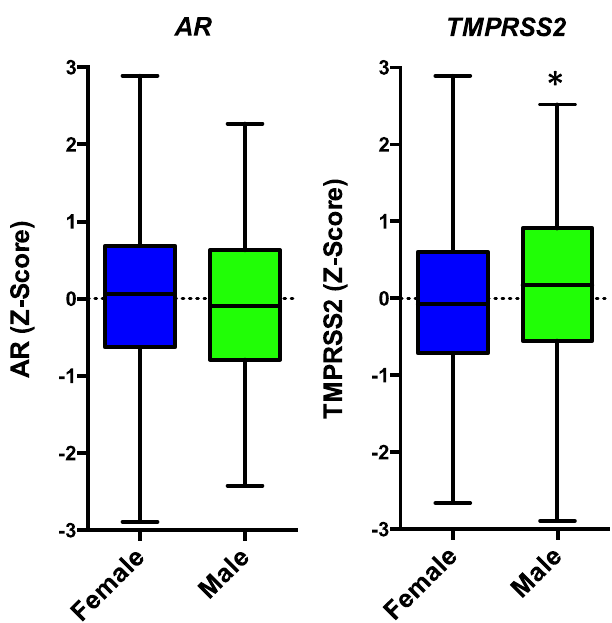
Fig. 3 TMPRSS2 is expressed at higher levels in the male lung compared to female lung. The GTEx dataset 40 was interrogated and expression of AR and TMPRSS2 investigated in lung tissue and dichotomised by gender, M = male ( N = 220), F = female ( N = 355). Box and whiskers: the centre line represents the median, the box represents the 25th and 75th percentile and the bars represent the min and max values. One-tailed t -test, * p =